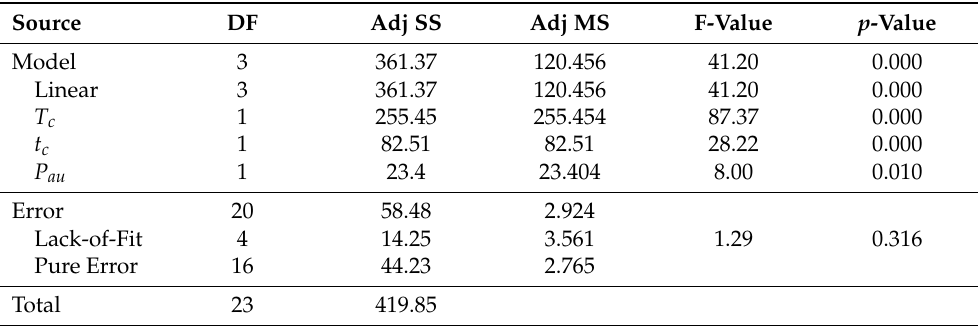
Table 5. ANOVA results for hardness. It was observed that only the main effect of T c , t c, and P au had a significant effect on the hardness of the